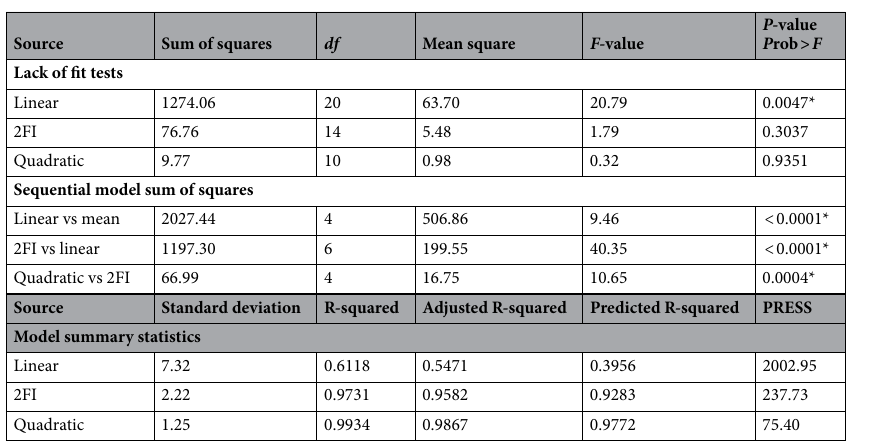
Table 5. Fit summary for Box–Behnken design results of copper (II) ions removal by using F. vesiculosus. df degree of freedom, PRESS sum of squares of prediction error, 2FI two factors interaction. *Significant values.